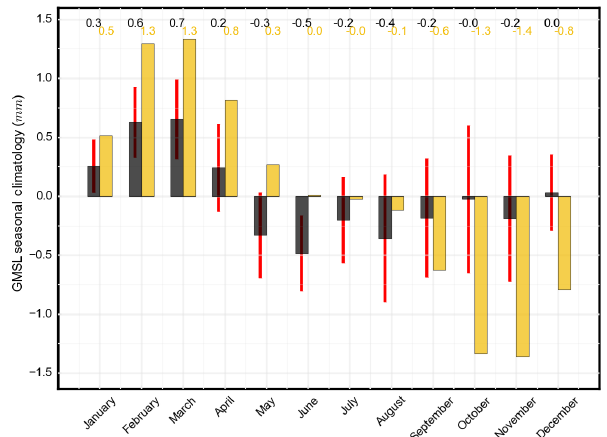
Figure 5. SL_cci v2.0 global MSL monthly climatology (yellow) compared with the ensemble mean (black) of the monthly climatol- ogy derived from different groups (DUACS DT2014, CSIRO, Col- orado University, GSFC and NOAA); the red bars show the asso- ciated SD. The period considered for the monthly average is 1993–